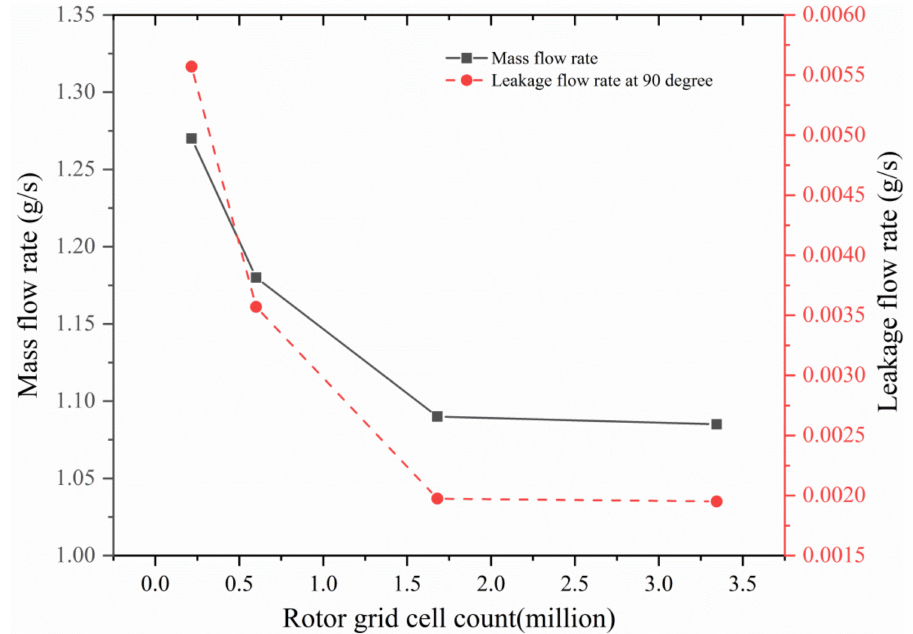
Figure 9. Rotor grid independence